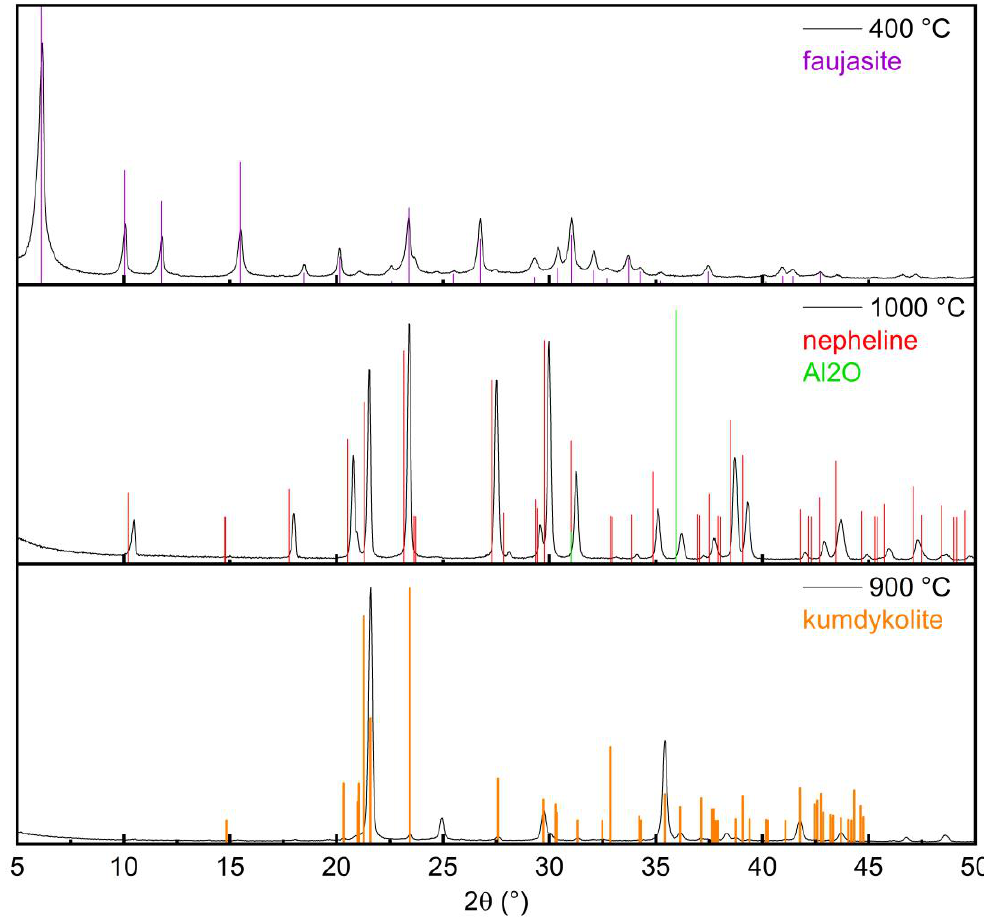
Figure 2: XRPD patterns of the LTX zeolite calcinated at 400 °C and a faujasite pattern as reference (top), the newly formed kumdykolite structure after high-temperature treatment at 900 °C (middle), and the nepheline structure (reference in red) with overlapping reflexes from Al 2 O (green) as an extra-aluminum framework after calcination at 1000 °C (bottom).